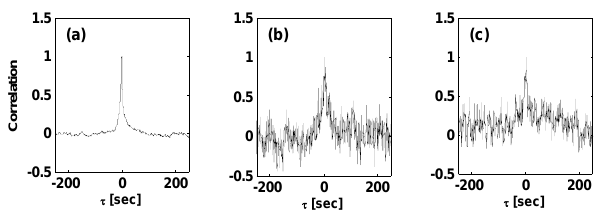
Figure 3. Lag calculation of (a) w’T’, (b) w’NO’ and (c) w’NO 2 ’. Highest normalized correlation between wind and temperature, NO or NO 2 were observed as expected; 0 second for wind and temperature, 1.4 and 2.6 second for NO and NO 2 .